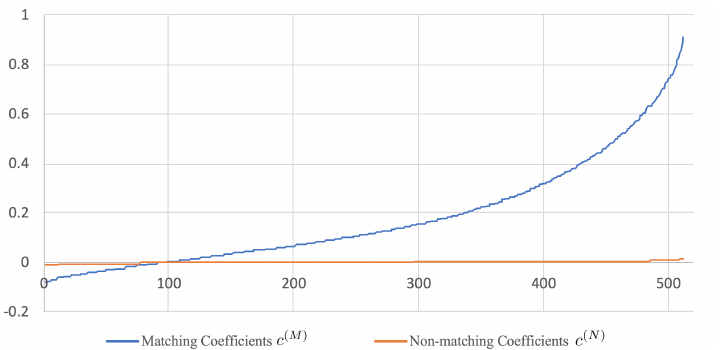
Figure 3. Profile of the diagonal elements of Λ and Π (i.e., c using AVE features. The CCA training was performed on the 120k-SfM dataset.